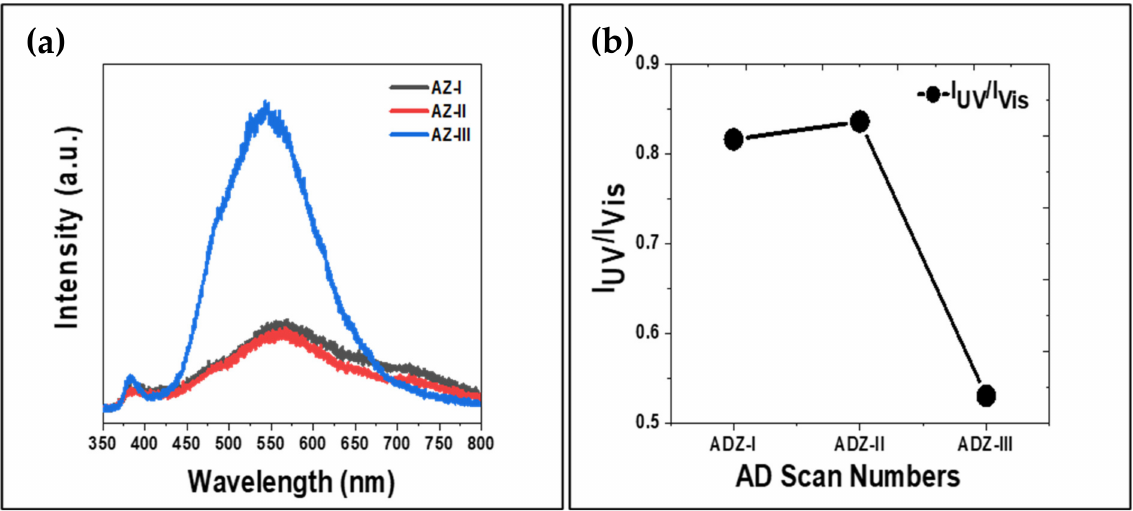
Figure 9. ( a ) RTPL spectra of the aerosol-deposited ZnO films, and ( b ) I UV /I Vis